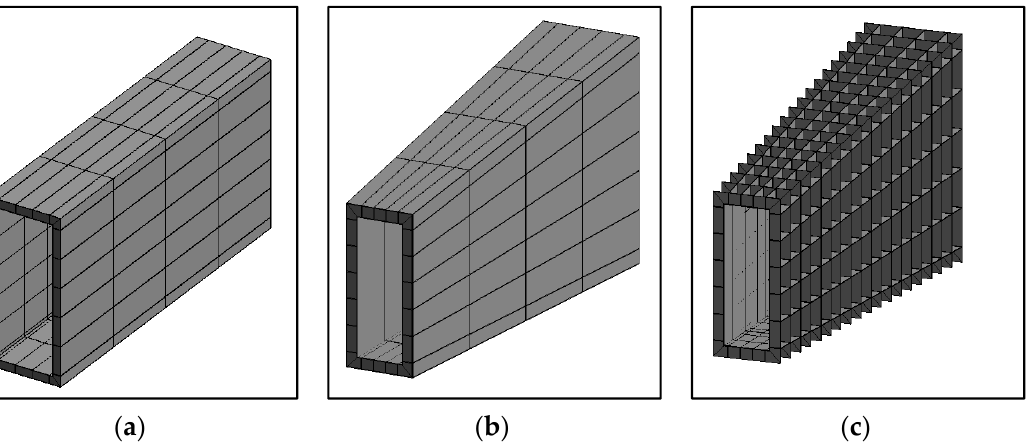
Figure 14. ( a ) Changes in the external dimensions; ( b ) Changes in the number of vertical stiffeners; ( c ) Model without external panels.